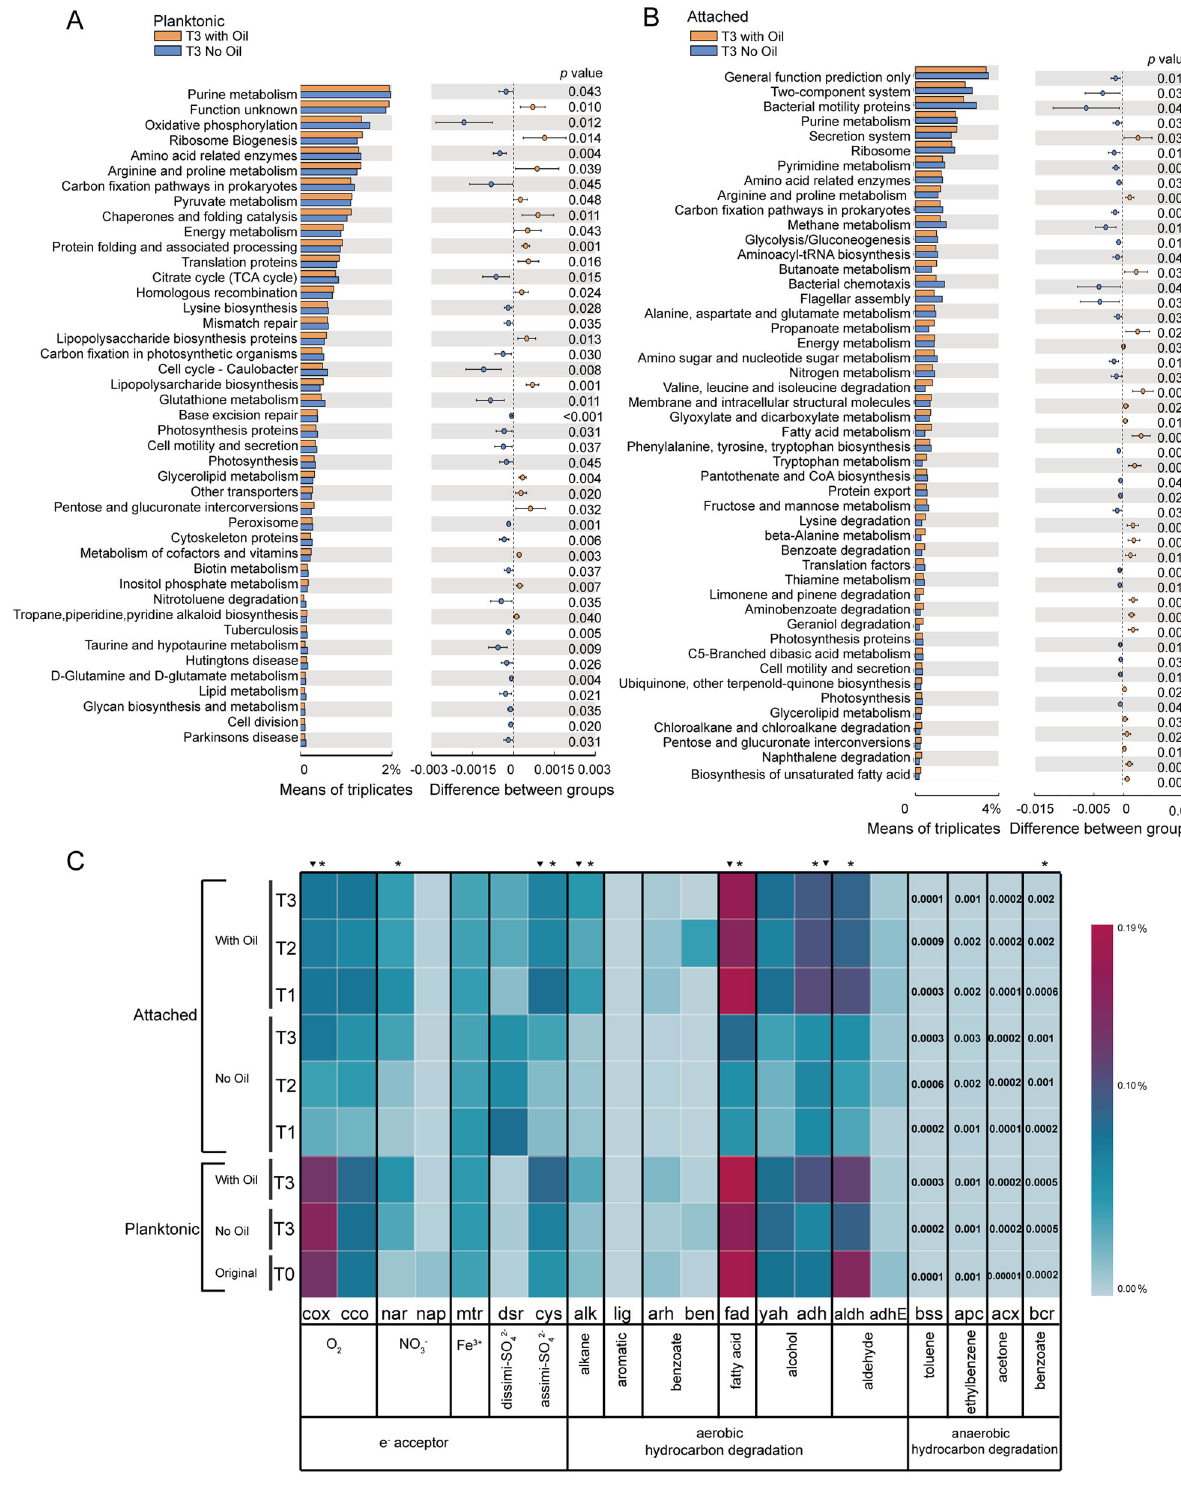
Fig. 6 Potential functions of the planktonic and attached microbial communities in seawater simulators during different culture stages with/without crude oil exposure using PICRUSt prediction. A The functional pathways of planktonic microbial community and B attached microbial community that signi fi cantly enriched in groups with/without crude oil for 85 days (T3). The left column showed the relative abundance of each pathway and the right column showed the difference between groups. C The abundance of important functional genes of the planktonic and attached microbial communities from day 0 (T0), day 25 (T1), day 55 (T2), and day 85 (T3). Signi fi cant differences ( P < 0.05) were analyzed by the T -test; “ ▾ ” and “ * ” indicated the signi fi cantly different genes between groups with/without crude oil from planktonic and attached samples for 85 days (T3), respectively. “ With Oil ” : With crude oil amendment; “ No Oil ” : Without crude